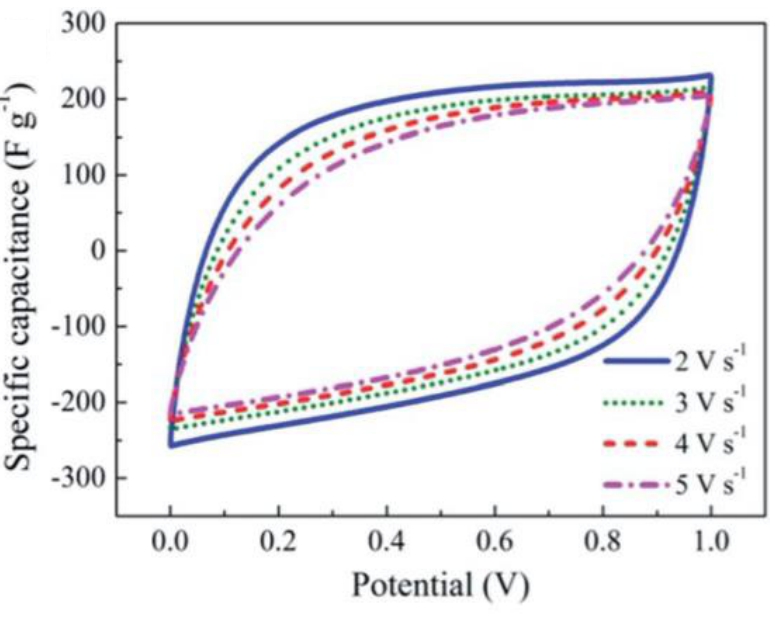
Figure 37. CV scan of UMCN-60 electrode at scan rate of 5 V/s (reproduced from the work in [79] with permission).